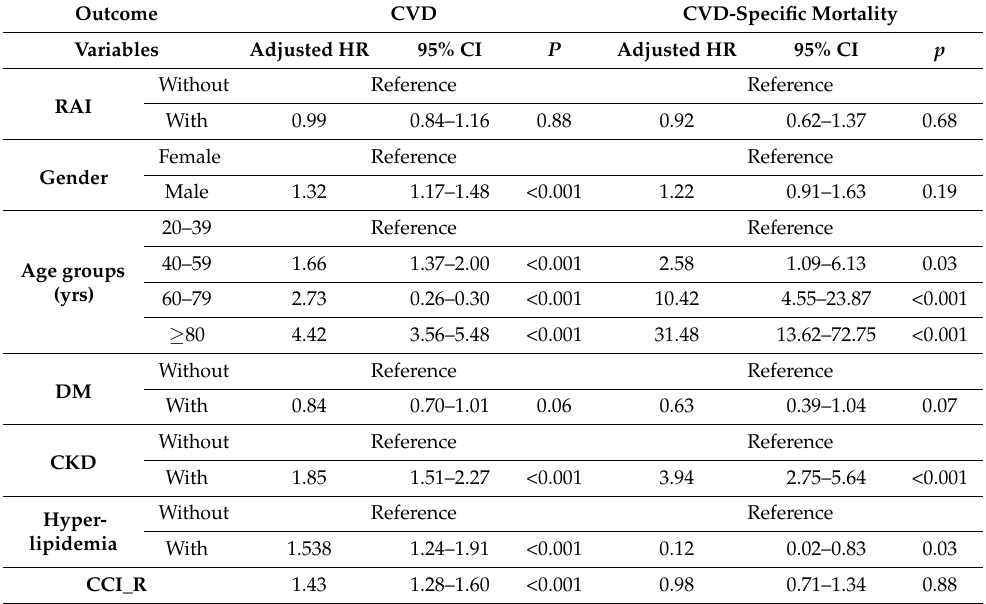
Table 2. Factors of CVD and CVD-specific mortality by using Cox regression.